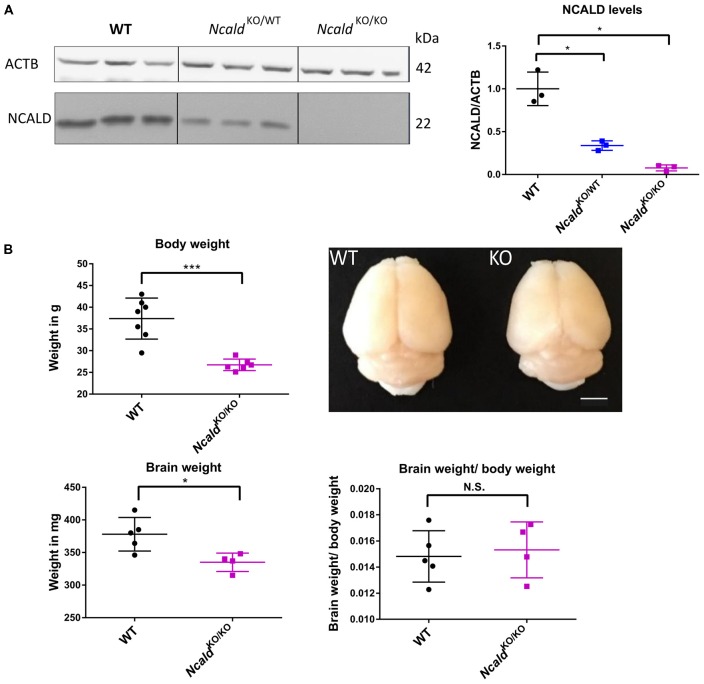
Neurocalcin delta (Ncald)KO/KO animals weight less and have smaller brains than wildtype (WT) littermates. (A) Western blot analysis of brain lysates from WT, NcaldKO/WT and NcaldKO/KO mice showing a significant reduction of NCALD in NcaldKO/WT animals and absence of NCALD in NcaldKO/KO animals; *P > 0.05. (B) Body weight of 5-month-old NcaldKO/KO males is significantly reduced (N = 6) compared to their WT littermates (N = 7); P < 0.05. Representative images of 4-month-old NcaldKO/KO (N = 4) and WT (N = 5) littermate brains and dot plot quantifications, indicating significantly smaller brains, but no significant changes in brain-to-body mass ratio in NcaldKO/KO animals compared to WT littermates; scale bar 100 pixels; *P < 0.05; ***P < 0.005; N.S. = not significant. Uncropped Western blots are included in Supplementary Data Sheet 8.